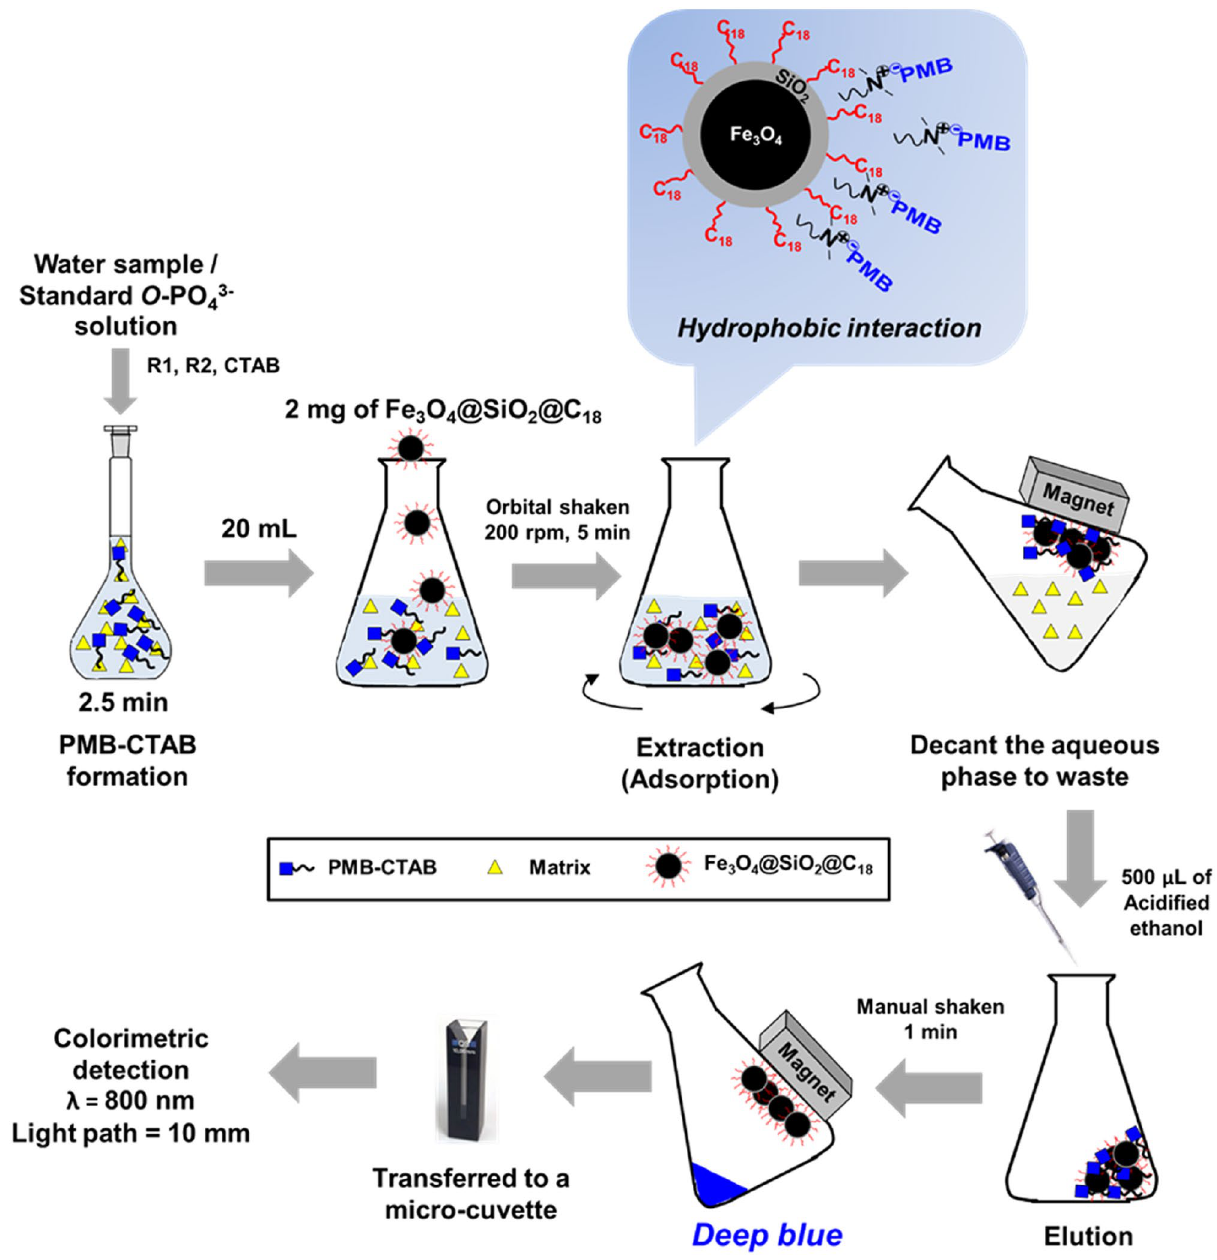
Figure 1. Schematic illustration of d-MSPE procedure for determination of o- PO 43− as PMB–CTAB complex using Fe 3 O 4 @SiO 2 @C 18